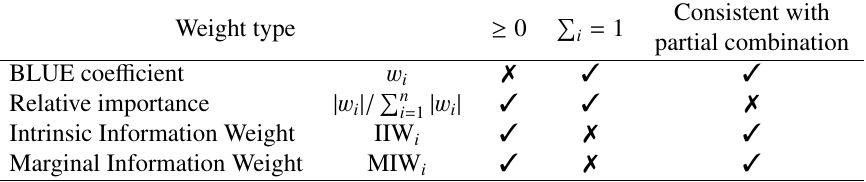
Table 1. Properties of the di ff erent quantities proposed for the BLUE combination